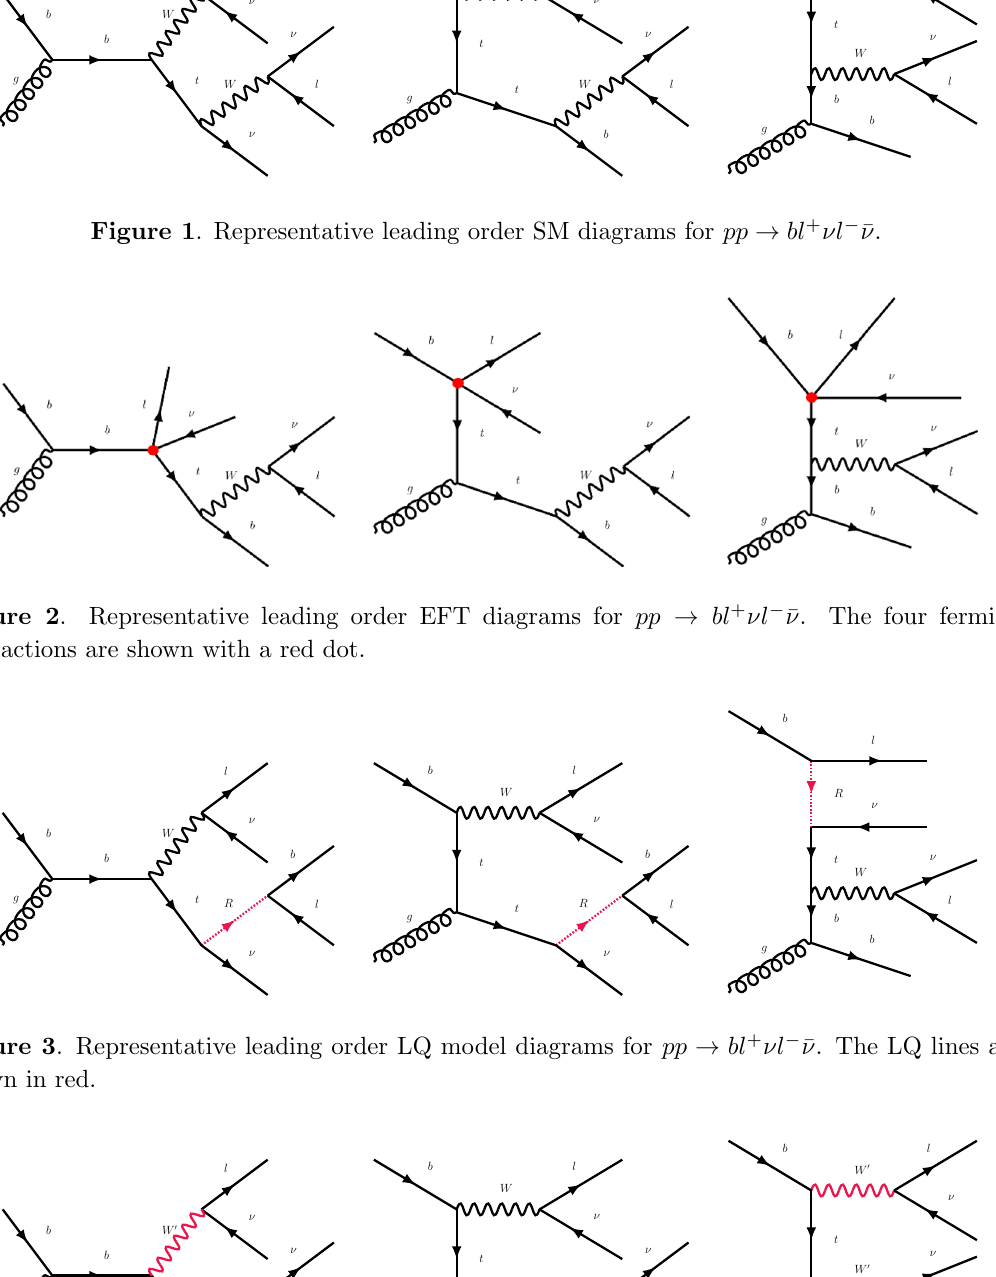
bl + (cid:23)l (cid:0) (cid:22) (cid:23) . The W 0 lines are !